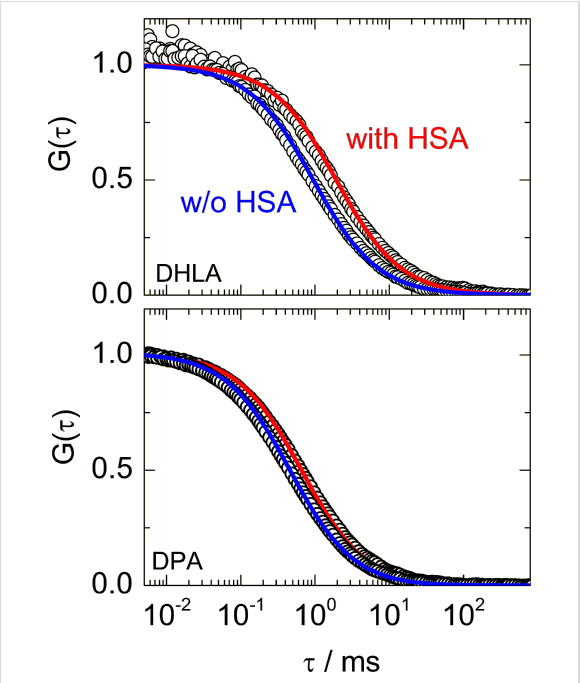
Figure 2: Normalized fluorescence intensity autocorrelation curves of (a) DHLA- and (b) DPA-stabilized QDs dissolved in PBS without (blue) and with (red) HSA at concentrations ensuring complete surface coverage ((a) 800 µM, (b) 40 µM HSA). Symbols: data, lines: